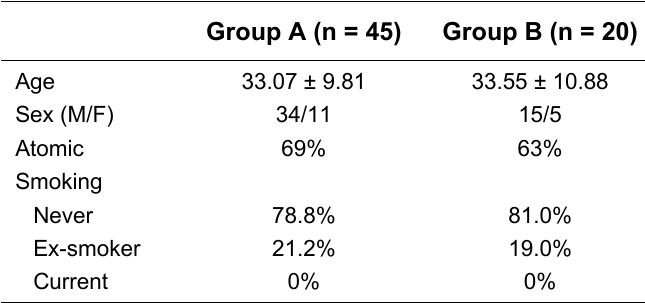
Demographic Characteristics of the